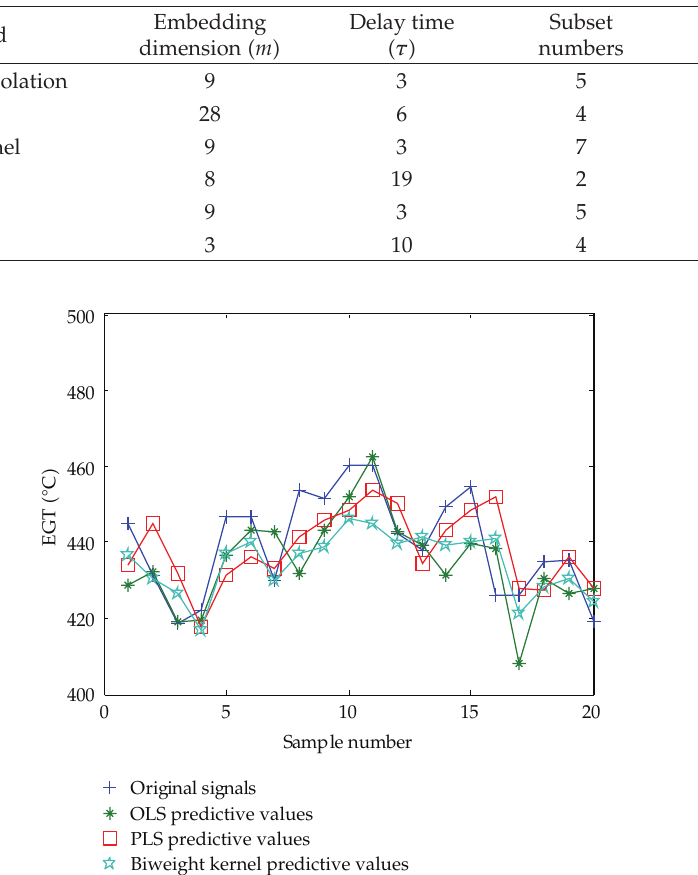
Figure 2: Comparison of original values and predictive